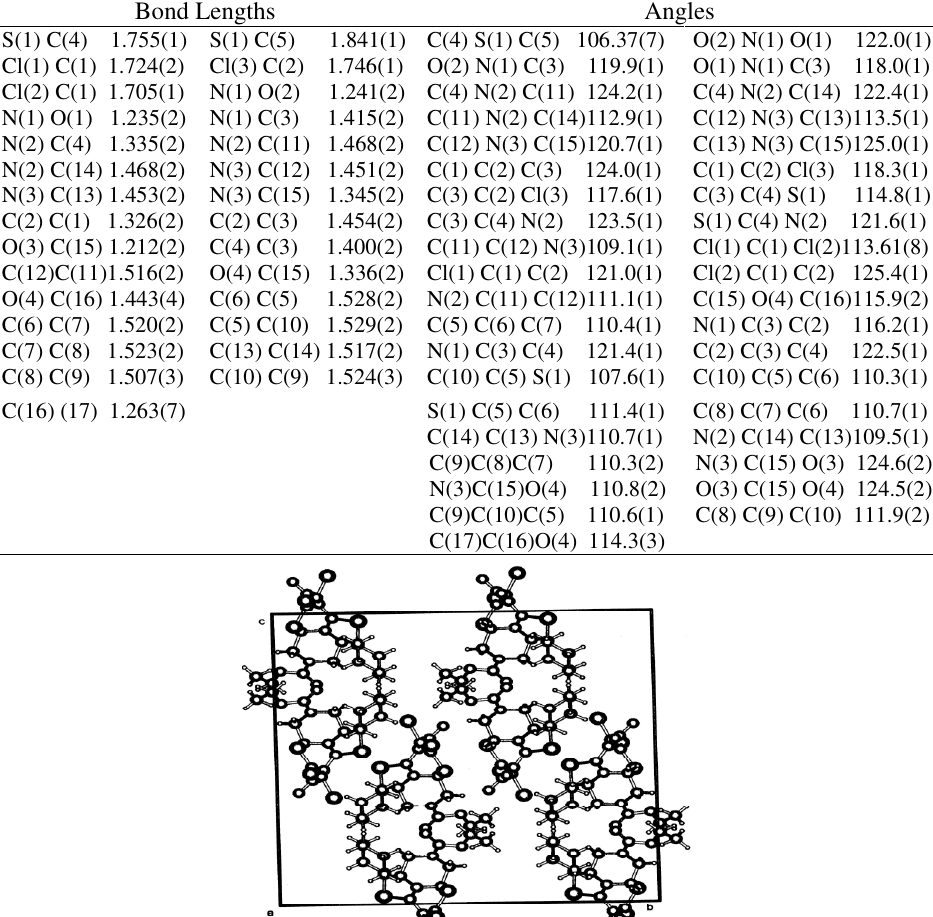
Table 2. Selected bond lengths [Å] and angles [ o ] for compound 4g Bond Lengths